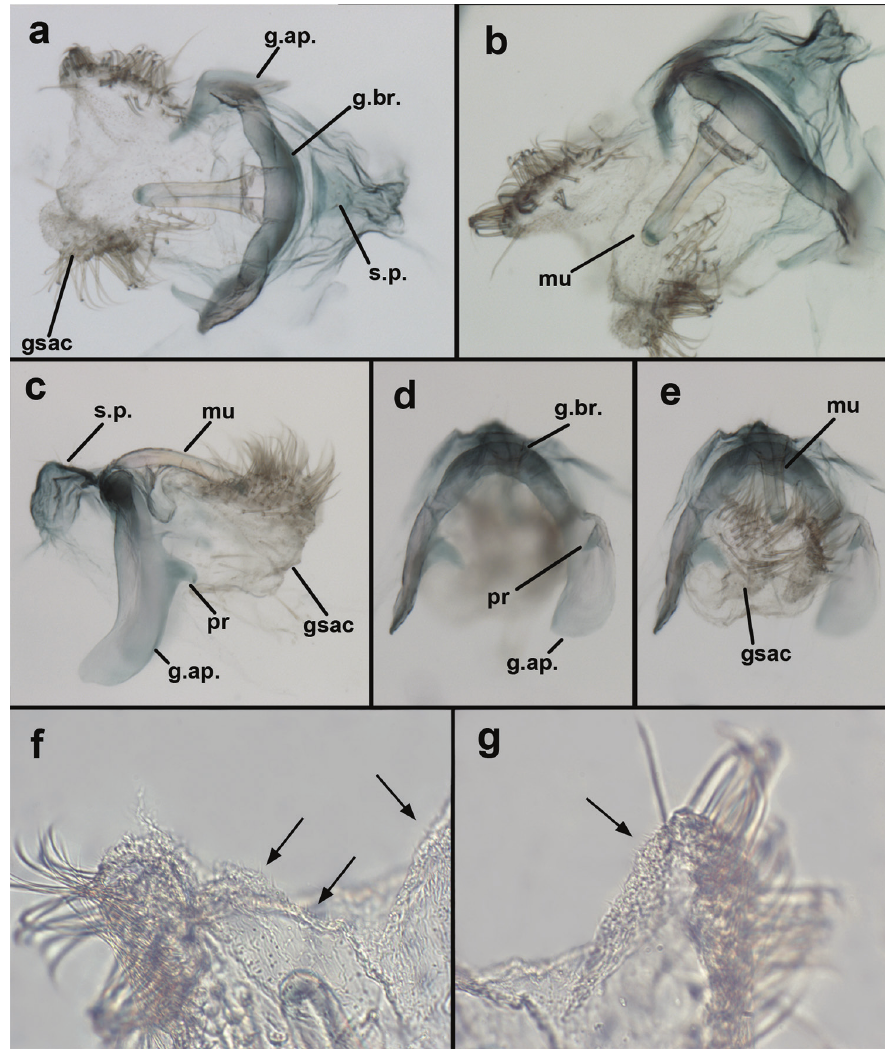
Figure 76. Ungla pennyi Tauber, sp. n. Male genitalia, ( a ) gonarcal complex, dorsal, with gonosaccus fully expanded ( b ) gonarcus, dorsal [Note internal structure of mediuncus.] ( c ) gonarcus, lateral ( d ) gonarcus, frontal, with mediuncus, gonosaccus obscured, position of left gonarcal apodeme slighltly dis- torted ( e ) gonarcus, frontal, with mediuncus, gonosaccus visible ( f, g ) inner, opposing (spiny) surfaces of gonosaccus lobes [Arrows indicate spines on surface of lobes.]. gsac gonosaccus g.ap. gonarcal apodeme g.br. gonarcal bridge mu mediuncus pr unarticulated process on frontal margin of gonarcal apodeme s.p. setose subanal plate (Costa Rica, Cartago, holotype,